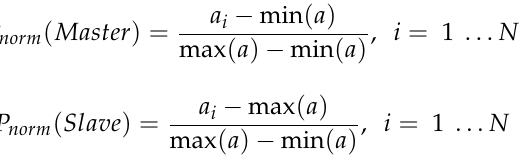
Figure 15. Normalized estimated perturbation of master and slave for end effector. Figure 16 shows the experimental result of the master–slave trajectories for the 2nd link. The blue line shows the experimental result of the master device, whereas the red line shows the experimental result of the slave device by using SMCSPO. The slave device can also follow the master device. The maximum value of the trajectory is 60 degrees at 13.5 s. The 2nd link of the slave device can move between 0 and 90 degrees.